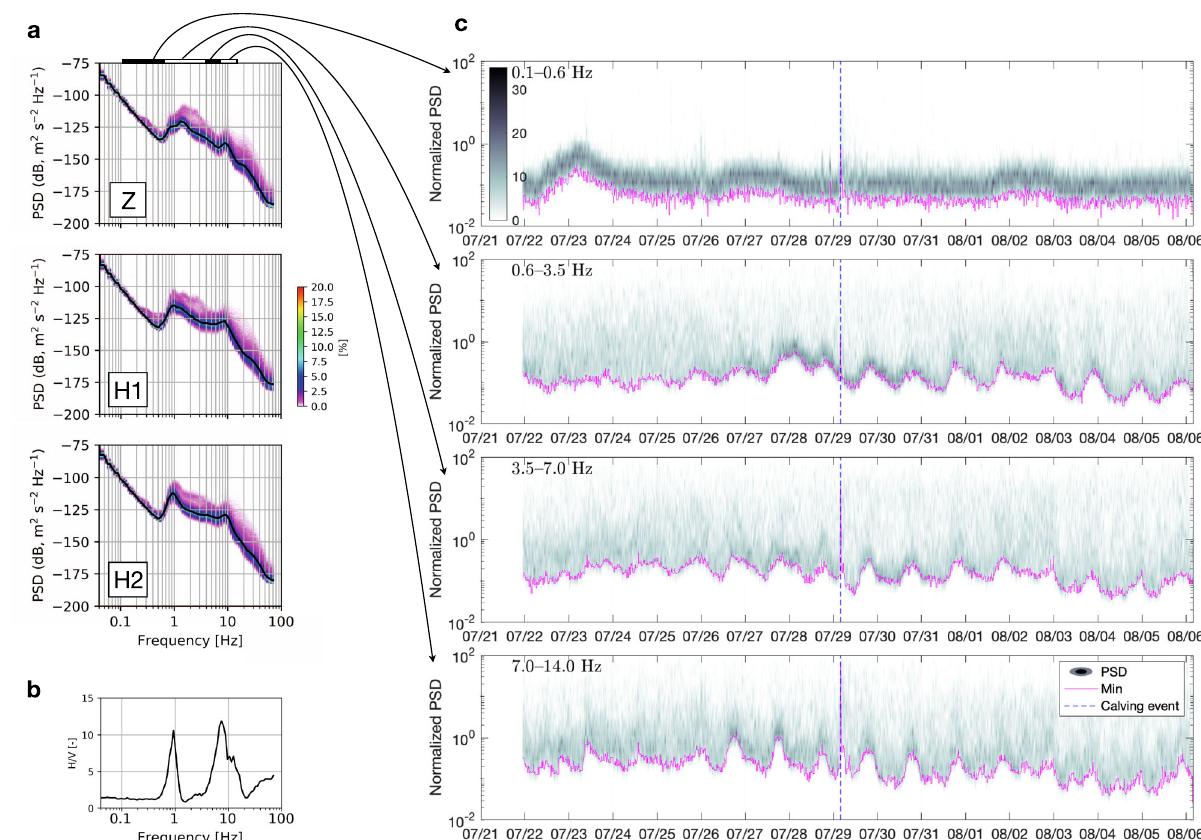
Fig. 2 Power partition of the continuous ocean-bottom-seismometer (OBS) data for various frequency bands, 2019. a Velocity spectra (power spectral density – probability density functions, PSD – PDFs) of the OBS three-component data. b Associated H/V spectral ratio (for accelerations). c Density plots of the normalized noise amplitude variation for all considered frequency bands. The magenta curve indicates the lowest noise level in each band. The dashed blue line indicates the timing of the major calving event on 29